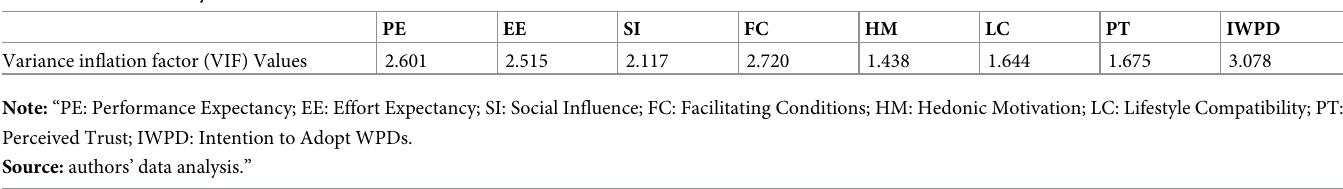
Table 2. Full collinearity